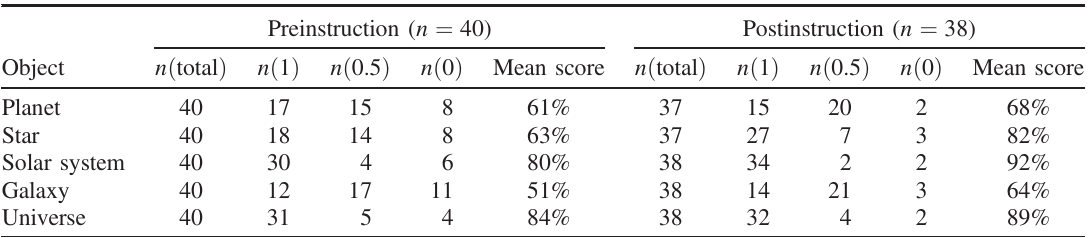
TABLE II. Preservice teachers ’ scores on the explaining task (Q5b), both pre- and postinstruction. For each object, the total number of students answering the question, the number of students scoring 0, 0.5, or 1 out of 1, and the mean score for the object is